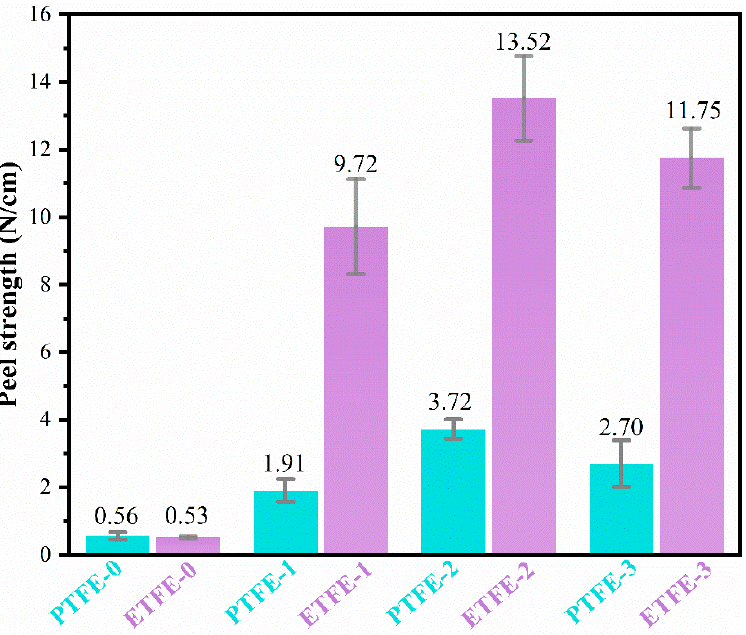
Figure 11. Comparison of the peel strength of ETFE and PTFE membranes before and after surface treatment.